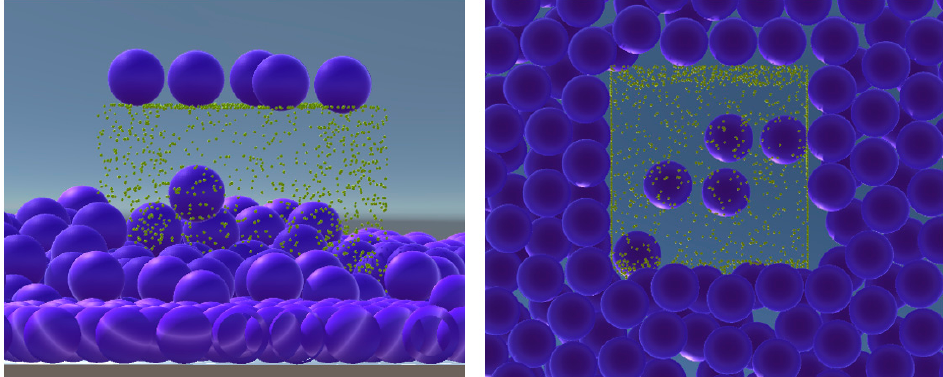
Figure 11. A VWD process for a cube, side length is 100, VWM diameter is 29.136. ( Left ) Front perspective; ( Right ) bottom perspective.